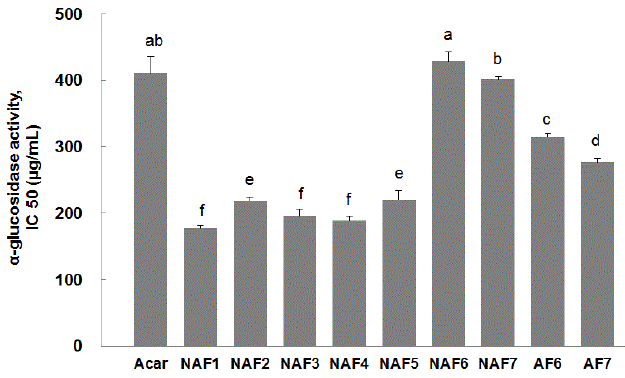
Fig. 3: Effect of mulberry extracts on α-glucosidase activity. IC 50 values (µg/mL) of compounds represent the concentrations causing 50% enzyme activity loss. Acar, acarbose; NAF, nonanthocyanin frac - tion (maturity stage1-7); and AF, anthocyanin fraction (maturity stage4-7). IC 50 of AF4 and 5 are more than 500 µg/mL. Bars repre - sent means ± standard deviations (n=3). Different letters (a-f) above the bars indicate significant differences by Duncan’s test at P